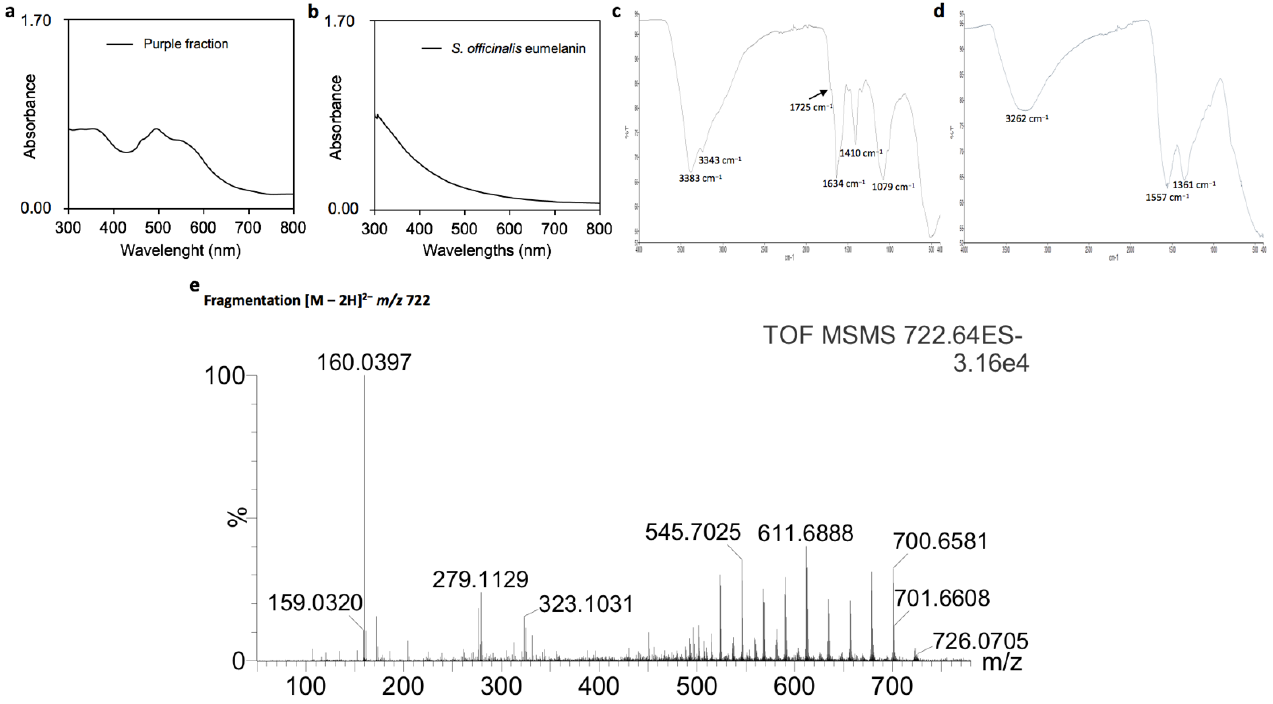
Figure 2. ( a , b ) Absorption spectra of PF and Sepia officinalis eumelanin, respectively; ( c , d ) FTIR spectra of PF and Sepia officinalis eumelanin, respectively; ( e ) MS/MS spectrum of the major acid-soluble pigment from PF ([M – 2H] 2− at m/z 722), adapted from reference [17].